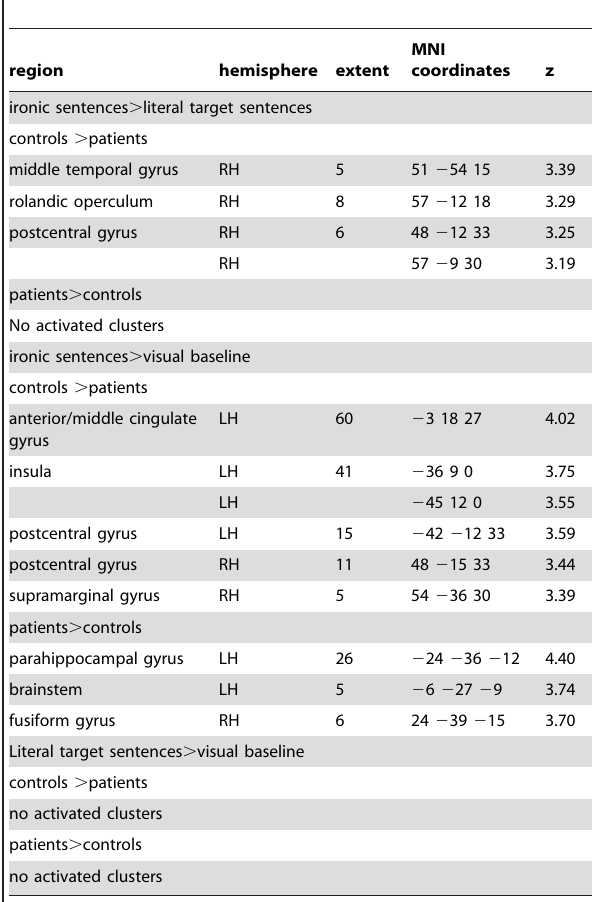
Table 2. Group comparison between healthy controls and schizophrenia. p , 0.001, ext. 5 voxels.